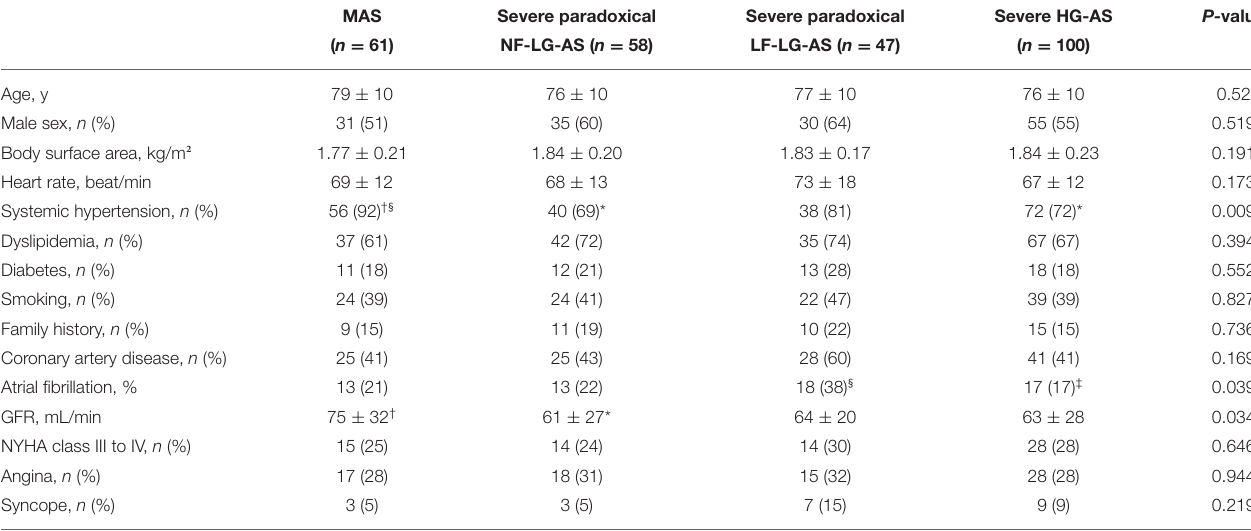
TABLE 1 | Baseline demographic and clinical characteristics.